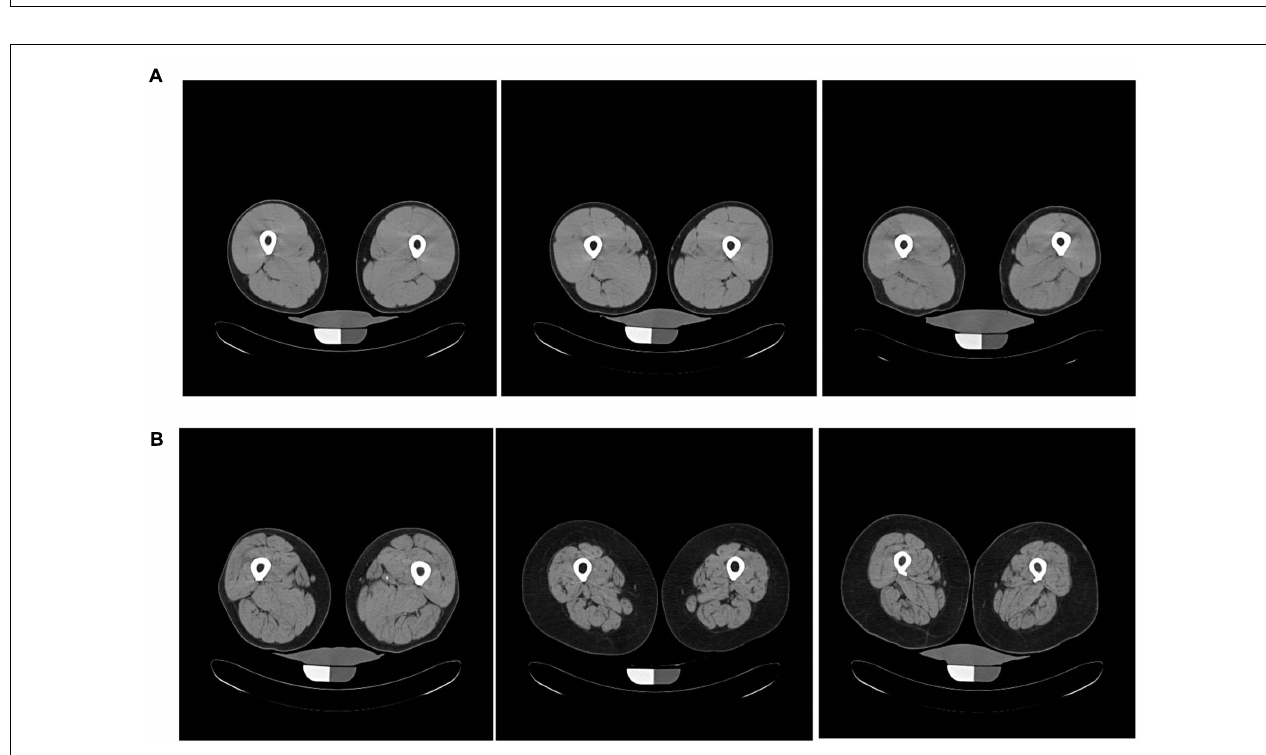
FIGURE 1 | 1 H-MRS spectrum obtained from a single voxel in thigh muscle at 3.0 T. Resonances of IMCL (1.25 ppm), EMCL (1.4 ppm), choline (3.2 ppm), and creatine (3.0 ppm) are well-resolved. Clear resolution between the IMCL and EMCL resonance peaks is seen, with residuals displayed above the spectrum.